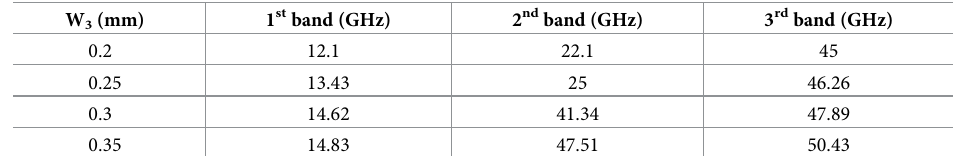
Table 2. Simulated result of quality factor for different values of W 3 .